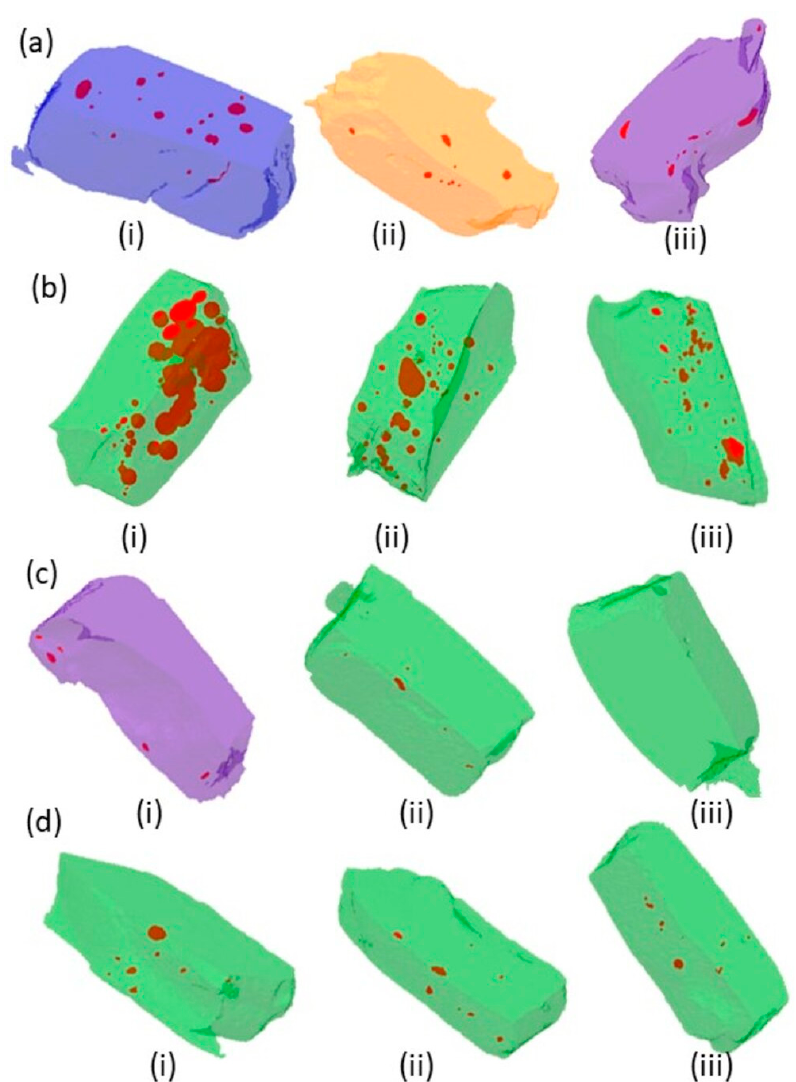
Figure 9. Micro-CT images showing representative samples of ( a ) Filtek Bulk-fill, ( b ) SDR, ( c ) Filtek Z250, and ( d ) Filtek Z350 after 60 s of ultrasonic activation. The images show presence of voids within the composite restorations, whereby SDR appears with maximum voids compared to the other groups.